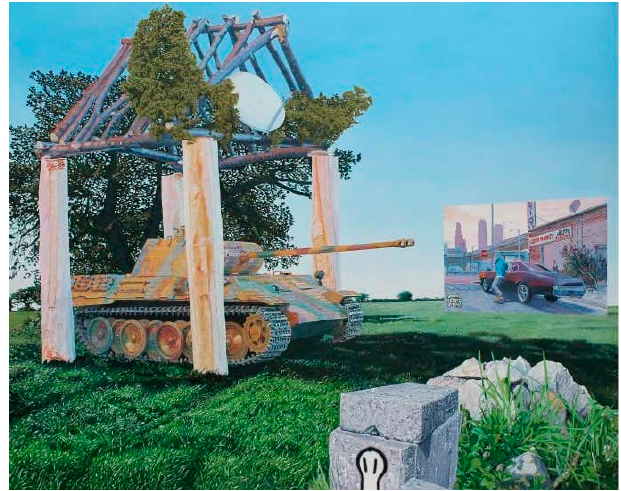
Figure 1. Paul Collinson, Heidegger’s Hut , 2015, oil on canvas, 120/150 cm. Courtesy of the artist.